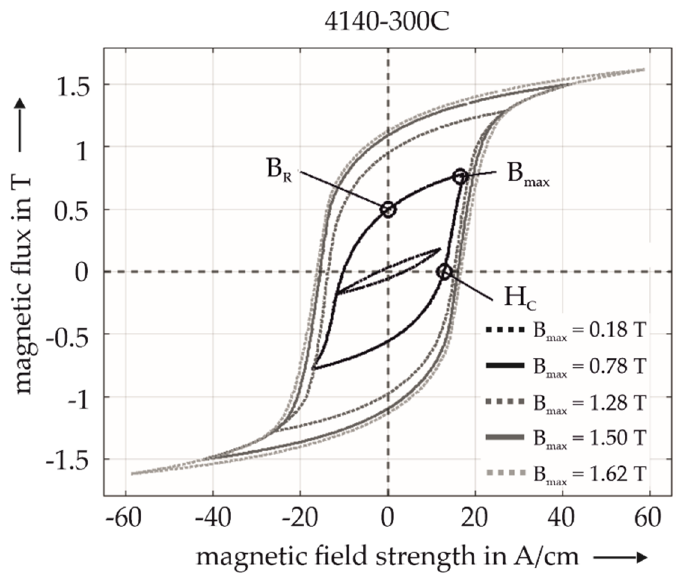
Figure 3. Magnetic hystereses of 4140-300C at different operating points.